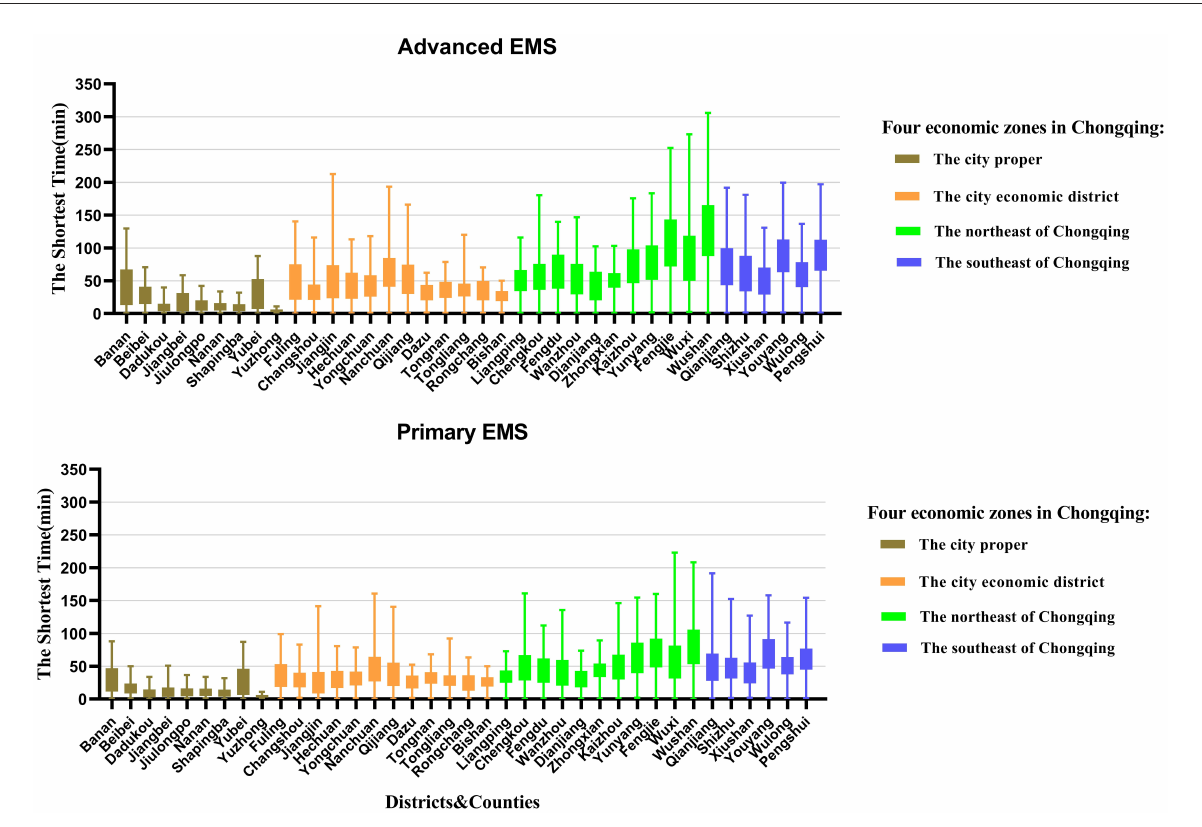
FIGURE5 Distribution of the shortest travel time to get primary and advanced emergency medical services (EMS) for each settlement in 38 districts/counties in Chongqing.